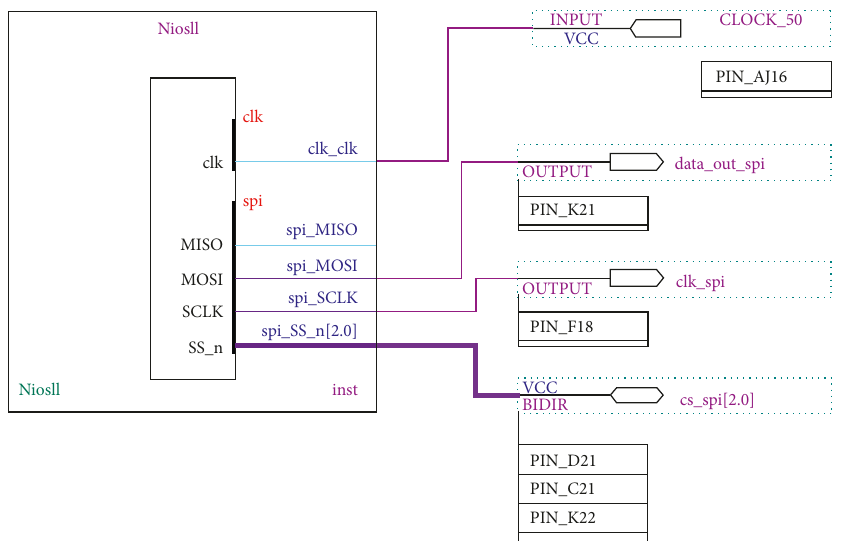
Figure 13: Schematic diagram of ES in V4 to implement the Nios II Entity and pins distribution on the FPGA U4.